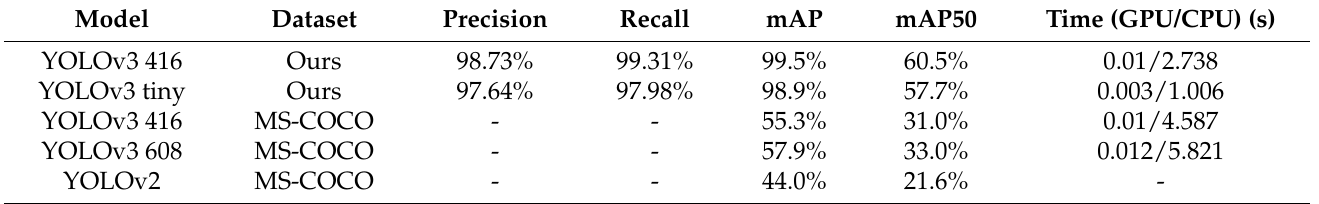
Table 4. Comparison of the accuracy results and detection time for different datasets using YOLO models.